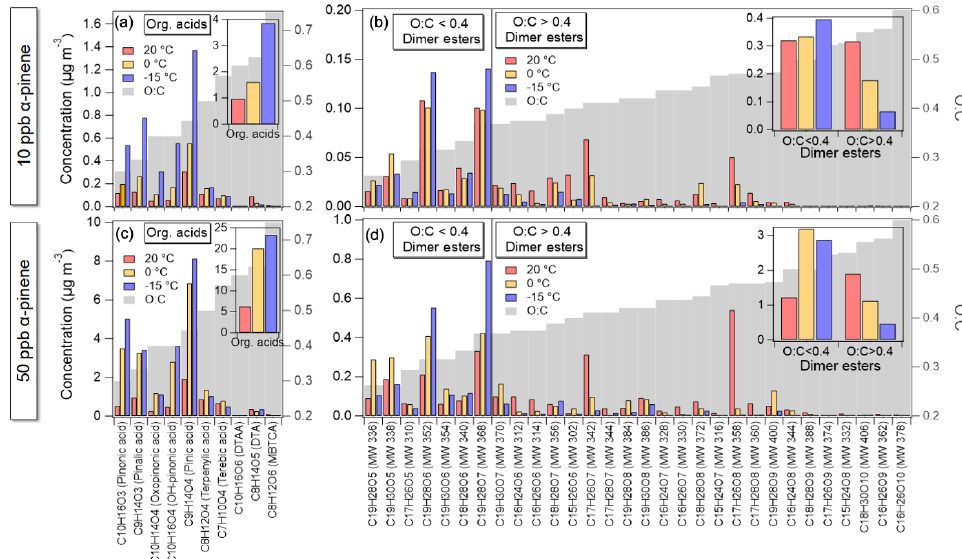
Figure 5. UHPLC/ESI-qToF-MS results showing mass concentrations (µgm − 3 ; left axis) of acids and dimer esters as well as O : C ratios (grey bars, right axis) of these at 20 ◦ C (red), 0 ◦ C (orange), and − 15 ◦ C (blue) for the two α -pinene concentrations: (a, b) 10ppb and (c, d) 50ppb. Insets show the total concentrations of the identified organic acids and dimer esters (O : C < 0 . 4 and O : C > 0 .